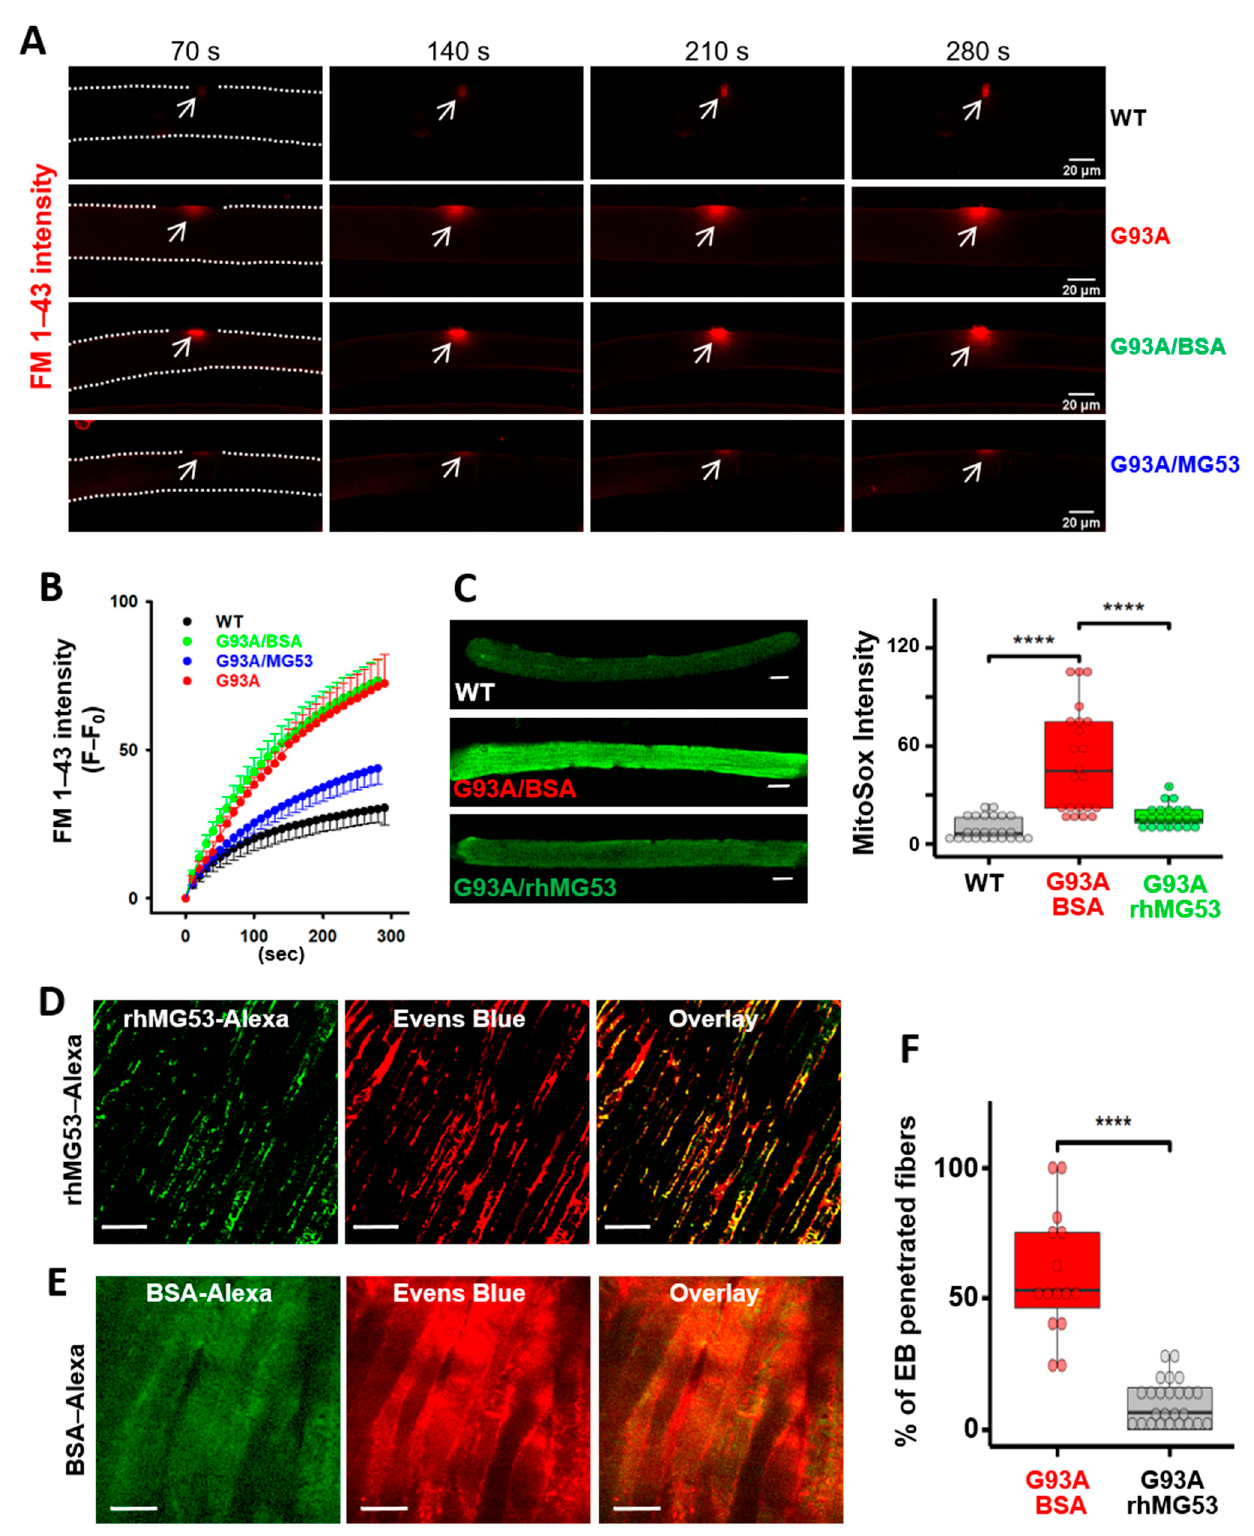
Figure 6. rhMG53 preserved membrane integrity of the diaphragm in G93A mice. ( A ) Time-lapse recordings of FM 1–43 accumulation in FDB myofibers after laser-induced membrane damage. The dashed lines highlight the myofiber outline. ( B ) Plotting of FM 1–43 intensity inside FDB myofibers over time after laser-induced membrane injury. Between G93A and WT ( n = 6–9 myofibers/group; p < 0.001), and between G93A/BSA (9 myofibers) and G93A/rhMG53 (10 myofibers) ( p < 0.001). ( C ) Live WT and G93A FDB myofibers pre-treated with rhMG53 (2 μ g/mL) or BSA (2 μ g/mL, as control) were